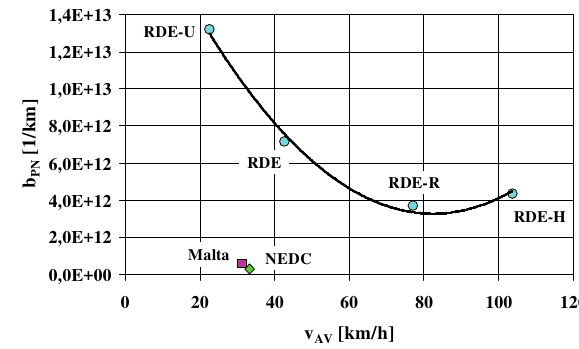
Fig. 20. The relation between the mean road emission of particles – b PN and the mean vehicle speed – v AV in each test